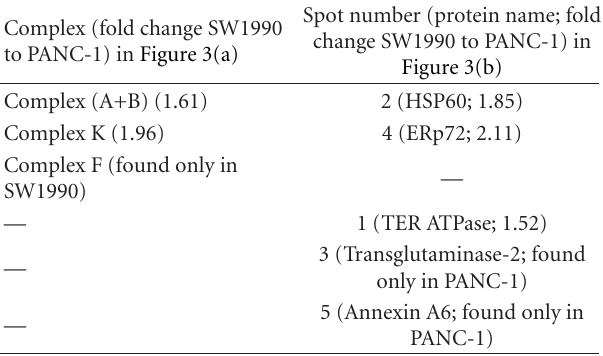
Table 2: Di ff erential protein complexes and di ff erential proteins between SW1990 and PANC-1 cell